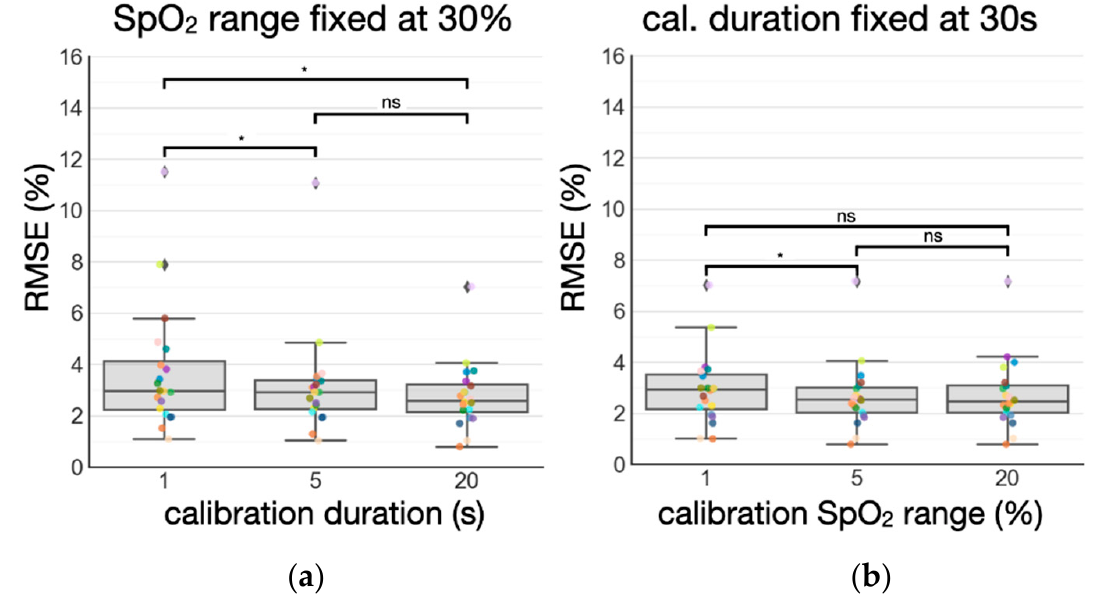
Figure 8. Calibration analysis. ( a ) RMSE is reduced significantly with increasing calibration duration while fixing SpO 2 range. ( b ) RMSE does not change significantly with increasing SpO 2 range while fixing calibration duration. ns denotes not significant ( p > 0.05), and a single asterisk denotes significant differences ( p < 0.05) as determined by paired sample t-tests.